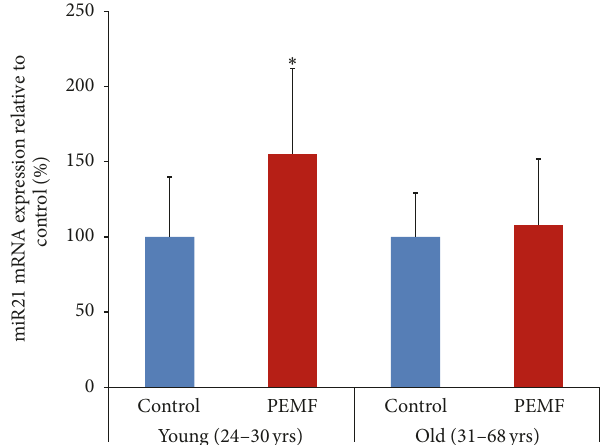
Figure 6: PEMF stimulated expression of miR21-5p in differentiated human osteoblasts. Total RNAs from control or PEMF-treated hBMSCs of females (24 × 2, 27, 29, and 30 years old, 𝑛 = 5 ) at day 23 of differentiation or (31, 36, 58, and 68 years old) at day 23 or 33 of differentiation were isolated and subjected to RT-qPCR using the miScript II kit with miScript HiSpec Buffer and miScript SYBR Green PCR Kit. snoR10-1 was used to normalize miR21- 5p expression and the expression is shown as a percentage of the relevant control samples. ∗ indicates significant increase compared to control using one-way